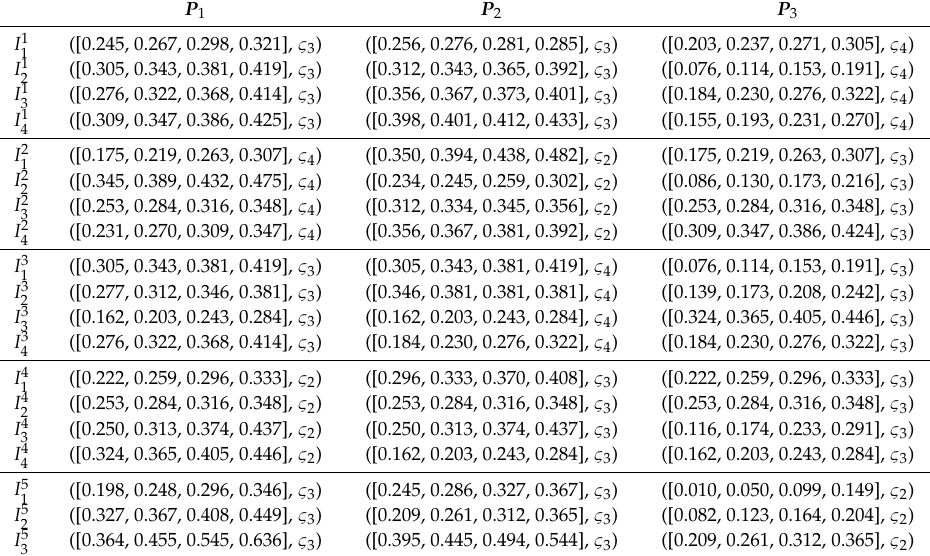
Table 2. Trapezoidal two-dimensional linguistic decision matrix ˜ E